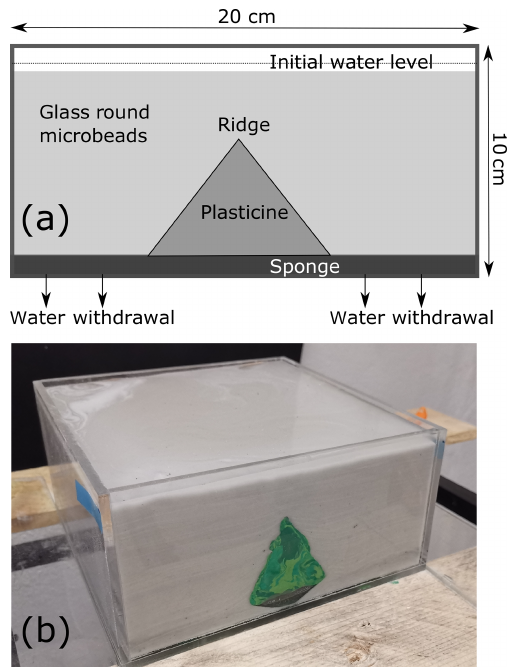
Figure 1. Sketch of the lab experimental setup (a) and photograph of the setup at the start of the experiment (b)